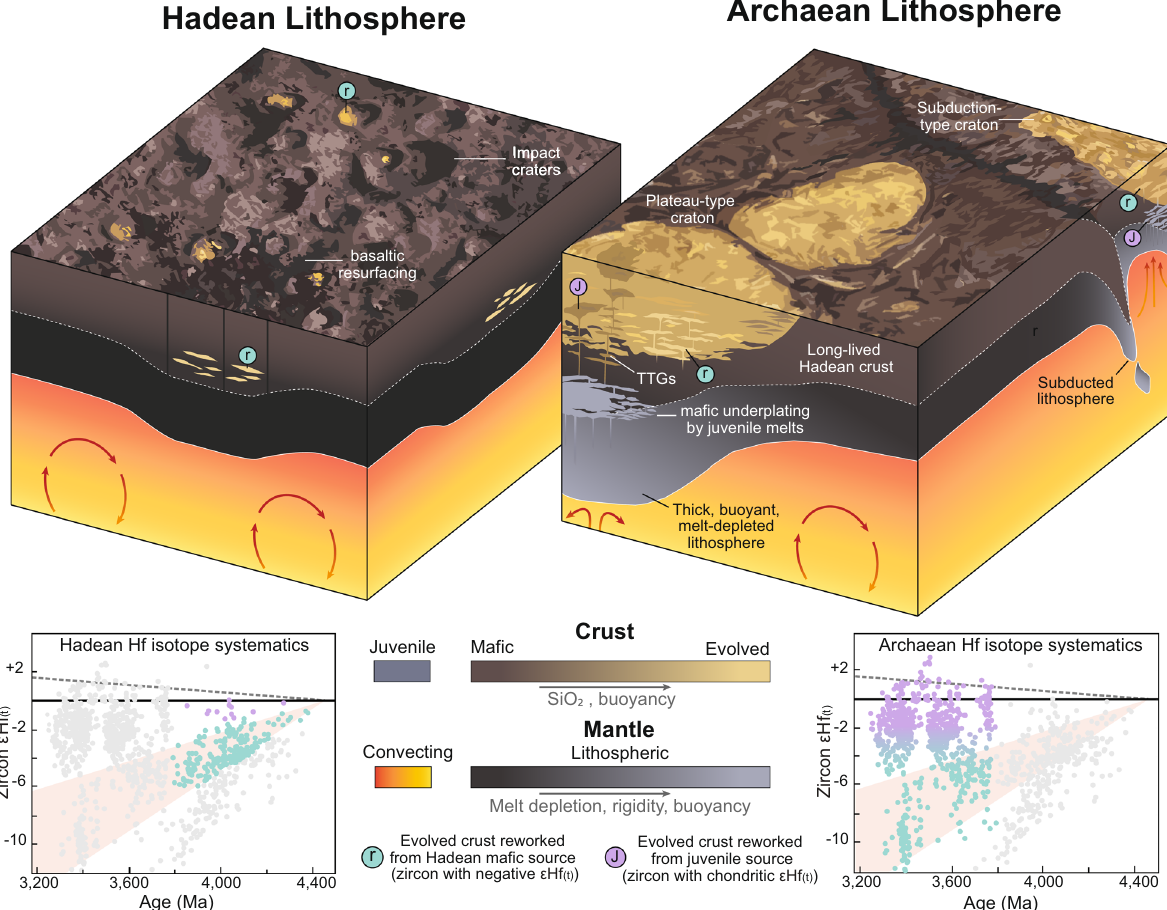
Fig. 4 Schematic diagrams illustrating changes in evolved crust-forming processes and lithospheric architecture between the Hadean and Archaean. The Hadean crust is predominantly ma fi c – ultrama fi c with minor evolved melts formed by internal differentiation or impact melting. Hadean crust persists into the Archaean and is reworked in subduction zones or thick crustal plateaus above mantle upwellings to form evolved magmas that crystallise zircon with negative ε Hf (t) . These two tectonic settings also facilitate adiabatic or fl ux melting of convecting mantle to form juvenile ma fi c magmas, which are reworked to produce evolved magmas that crystallise zircon with approximately chondritic ε Hf (t) . Juvenile melt extraction produces a complementary melt- depleted, rigid, and buoyant lithospheric mantle, which stabilises the evolved crustal nuclei of Earth ’ s fi rst cratons. The zircon ε Hf (t) – time plots show the corresponding zircon-Hf isotope characteristics of evolved crust from the Yilgarn craton between the Hadean and Archaean contemporaneously with the appearance of the fi rst stable, evolved crust in the Eoarchaean.